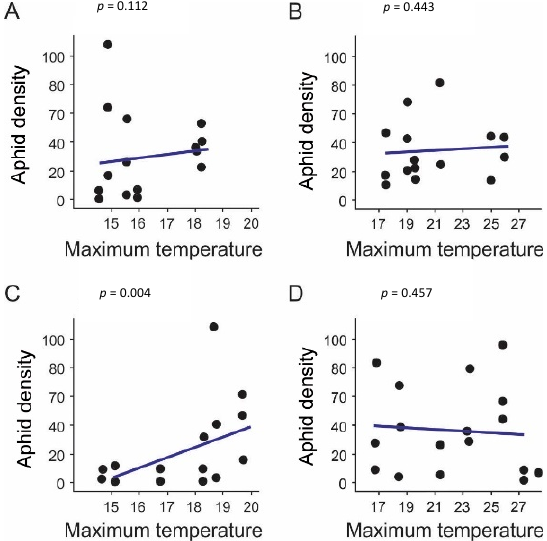
Figure 3. Effect of maximum temperature on aphid density (number of S. avenae per 100 wheat tillers). ( A ) Zone 1 and ( B ) Zone 2 throughout 2017; and ( C ) Zone 1 and ( D ) Zone 2 throughout 2018. p indicates the p -value obtained from a generalized linear mixed model (GLMM).